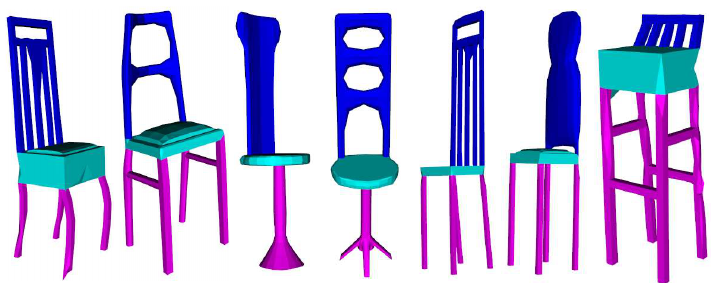
Figure 1. High-quality segmentation of